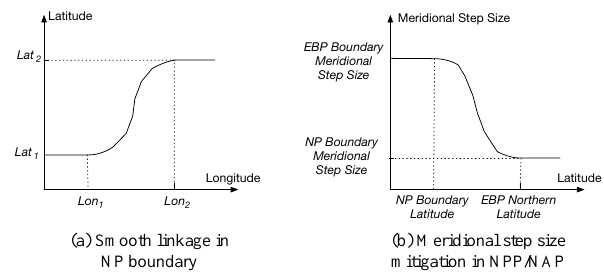
Figure 6. Smooth linkage of NP boundary and meridional step size